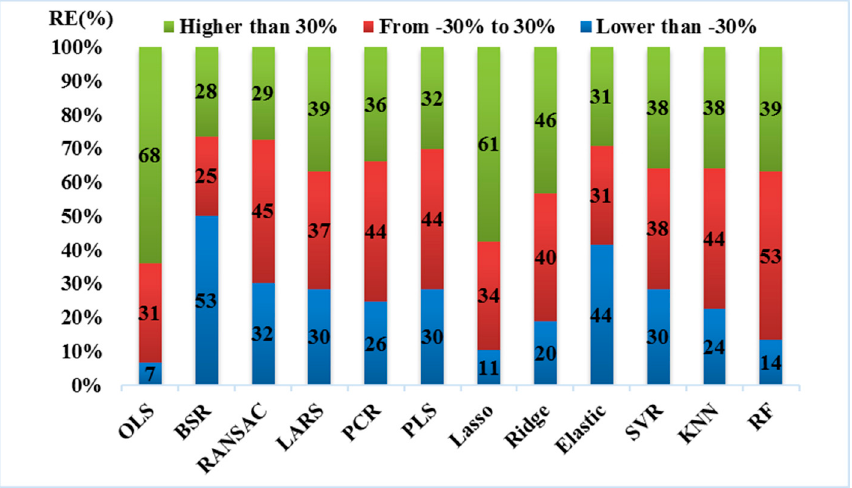
Figure 5. Grouping statistics for the proportion of subdistricts with different relative errors.